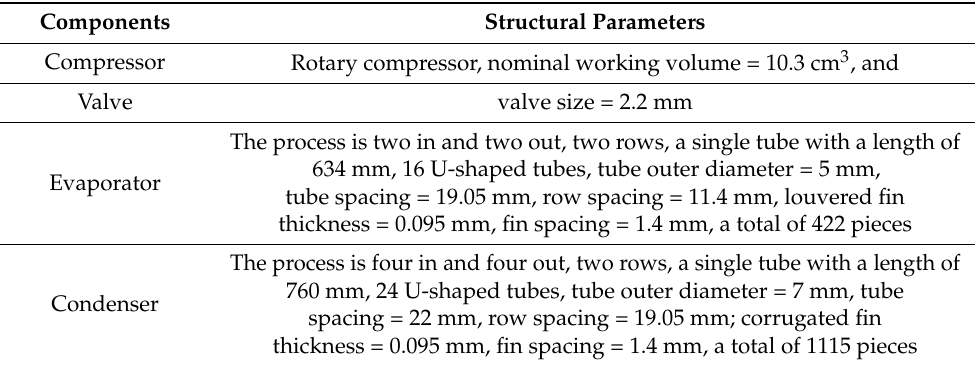
Table 1. Main structural parameters of the air conditioner.